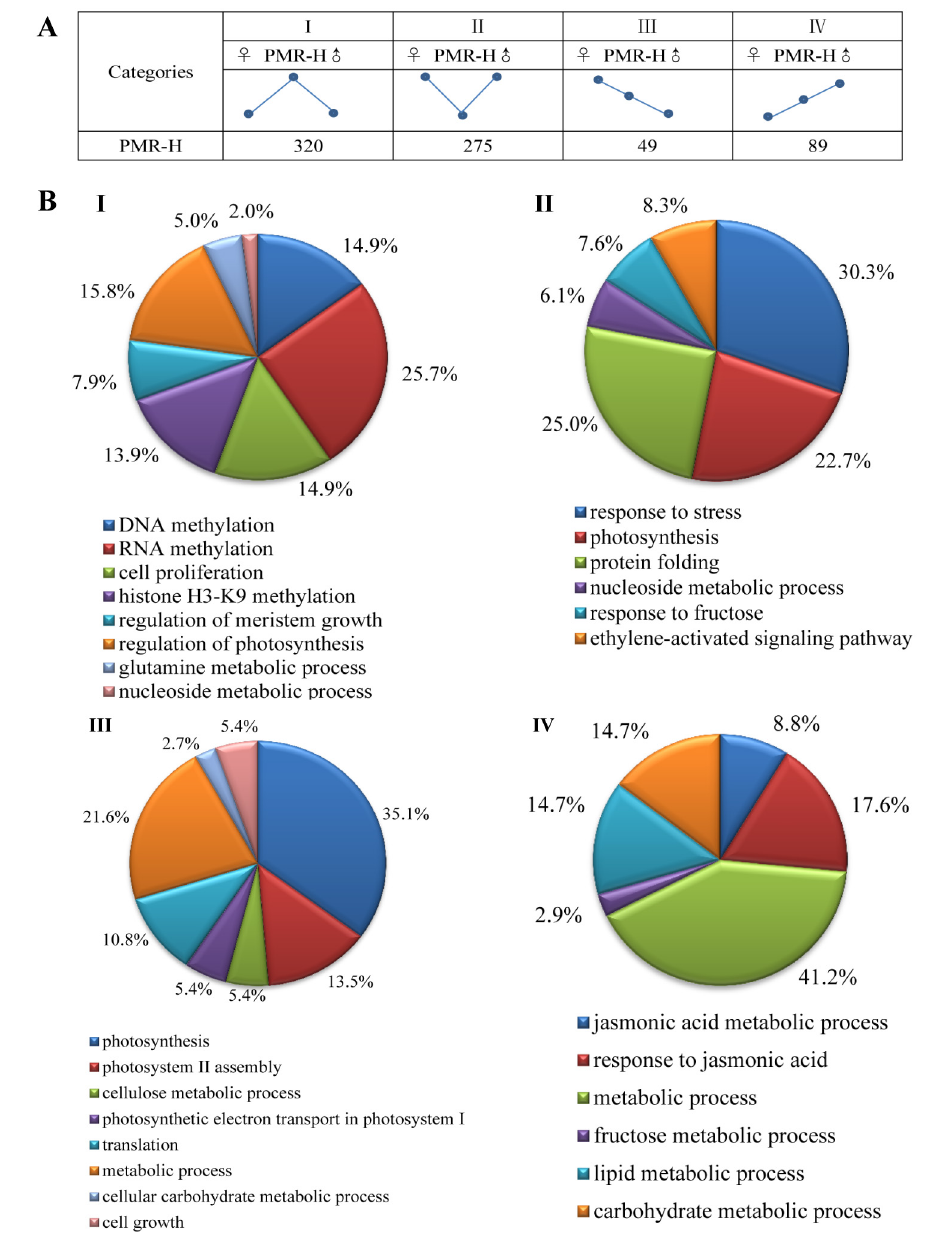
Figure 4. Differential gene expression categories (I–IV) in the high-growth allotriploid Populus progeny genotypes (PMR-H) relative to their diploid parents. ( A ) Four categories of the 791 DEGs in the overlapping region of the PMR-H and their parents; ( B ) Enriched GO terms of the genes in each